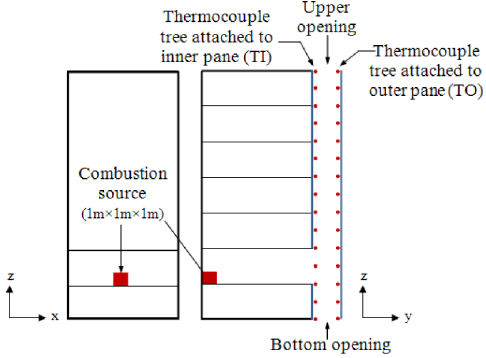
Fig. 2. Positions of thermocouples and the set of combustion source in DSF